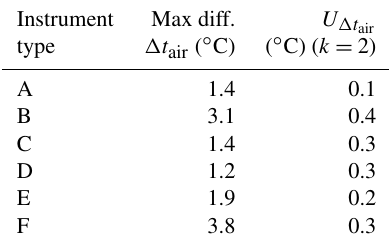
Table 6. Maximum difference, (cid:49)t air , for each manufacturer with the associated uncertainty from Table 5. Values are rounded at the first decimal, and U (cid:49)t is rounded up according to normative standards air (EA-4/02). Instrument Max